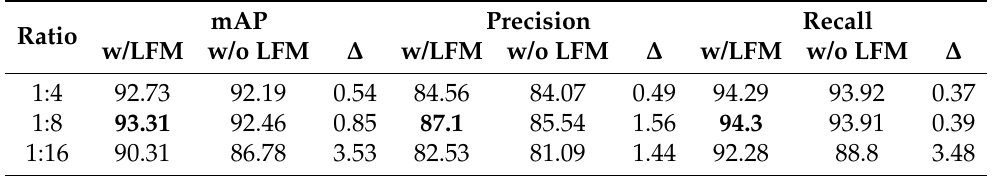
Table 2. Analysis of the feature aggregation enhancement pyramid network on the SSDD